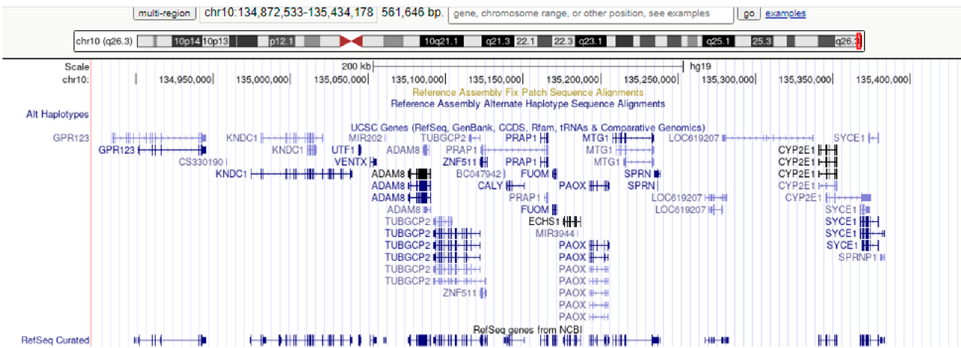
Figure 9. Genome Browser image of genes in the 10q26.3 region.